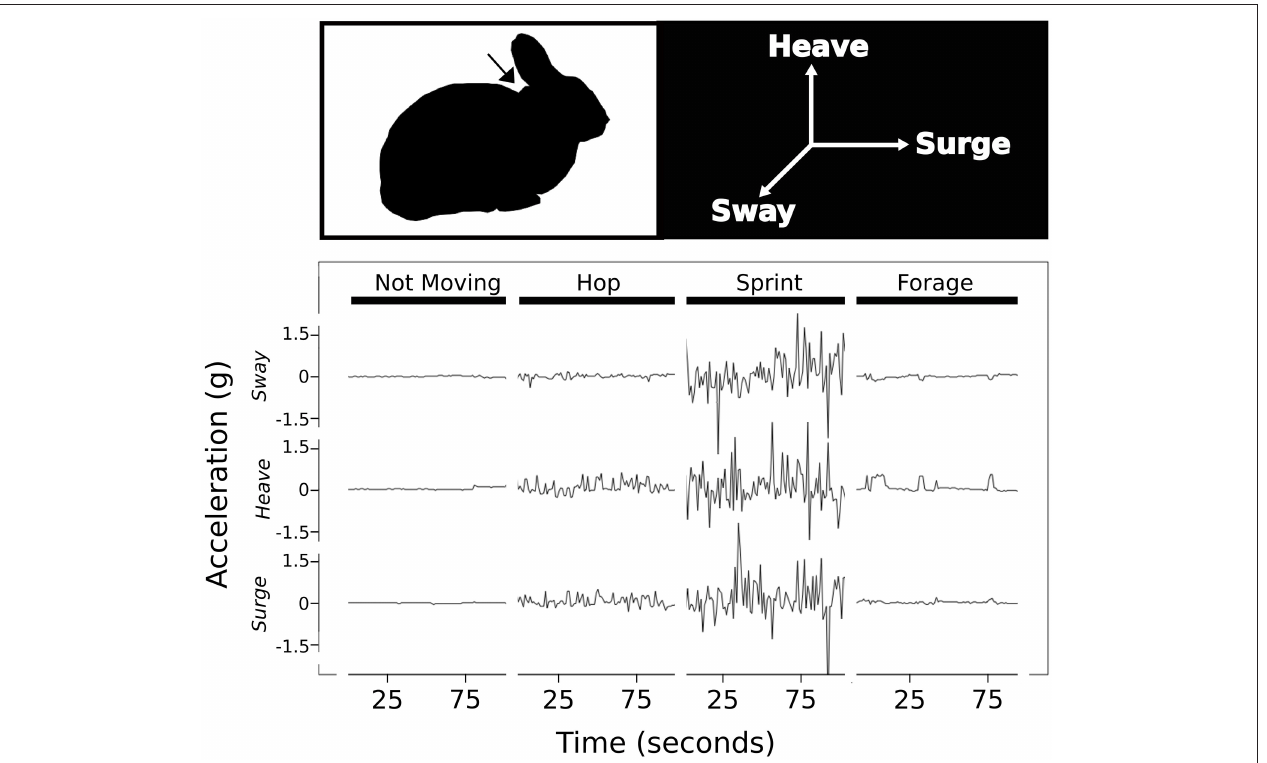
FIGURE 1 | Example of 1Hz tri-axis accelerometer data and the orientation axis from a collar attached to a captive snowshoe hare. Arrow indicates location where accelerometer rested on the